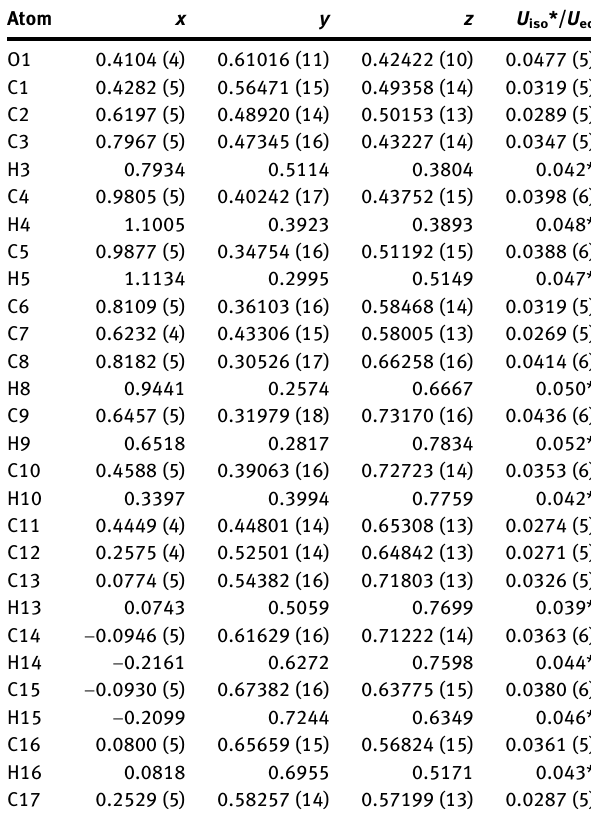
Table  : Fractional atomic coordinates and isotropic or equivalent isotropic displacement parameters (Å 